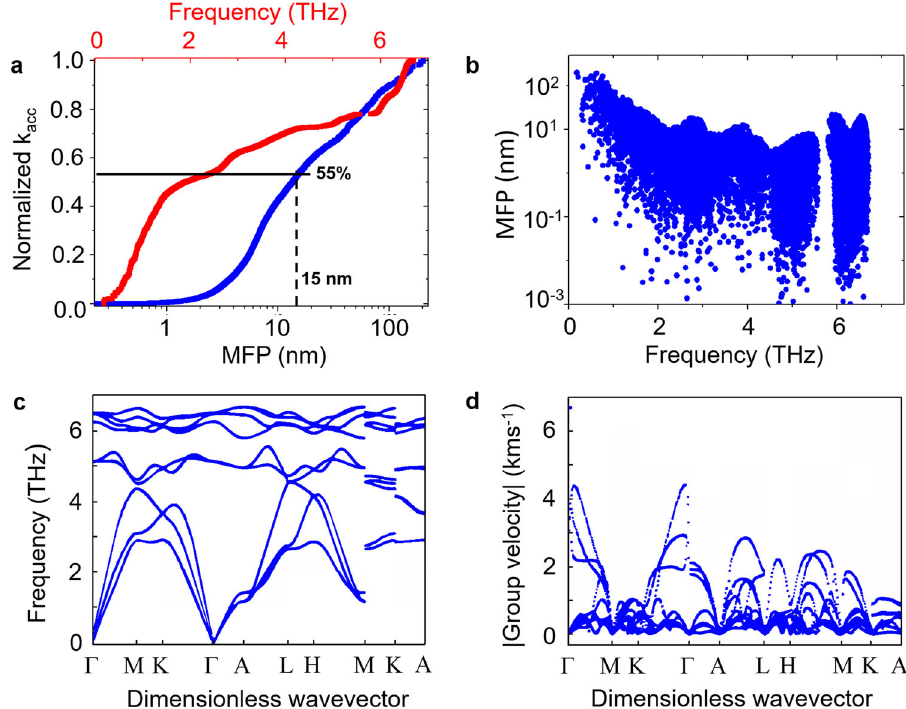
Fig. 4 First-principles DFT calculations. a Normalized thermal conductivity accumulation ( k acc ) as a function of the phonon frequency (red curve) and MFP (blue curve) for bulk PtSe 2 . b Calculated bulk phonon mean free as a function of frequency. c Phonon dispersion relations and d group velocity of bulk PtSe 2 along high-symmetry directions in the Brillouin